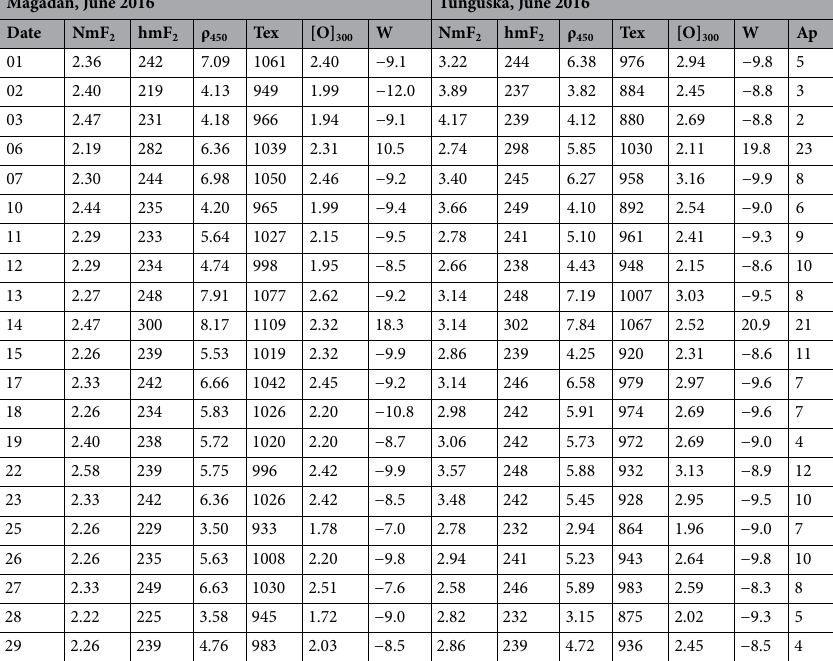
Table 1. Observed noontime NmF 2 (in 10 5 cm −3 ), swarm neutral gas density ρ (in 10 –16 g cm −3 ) reduced to the location of ionosonde, 450 km height, and 12 LT, inferred hmF 2 (in km), exospheric temperature Tex (in K), atomic oxygen [O] (in 10 8 cm −3 ) at 300 km, vertical plasma drift W (in m s −1 ), and daily Ap index (in